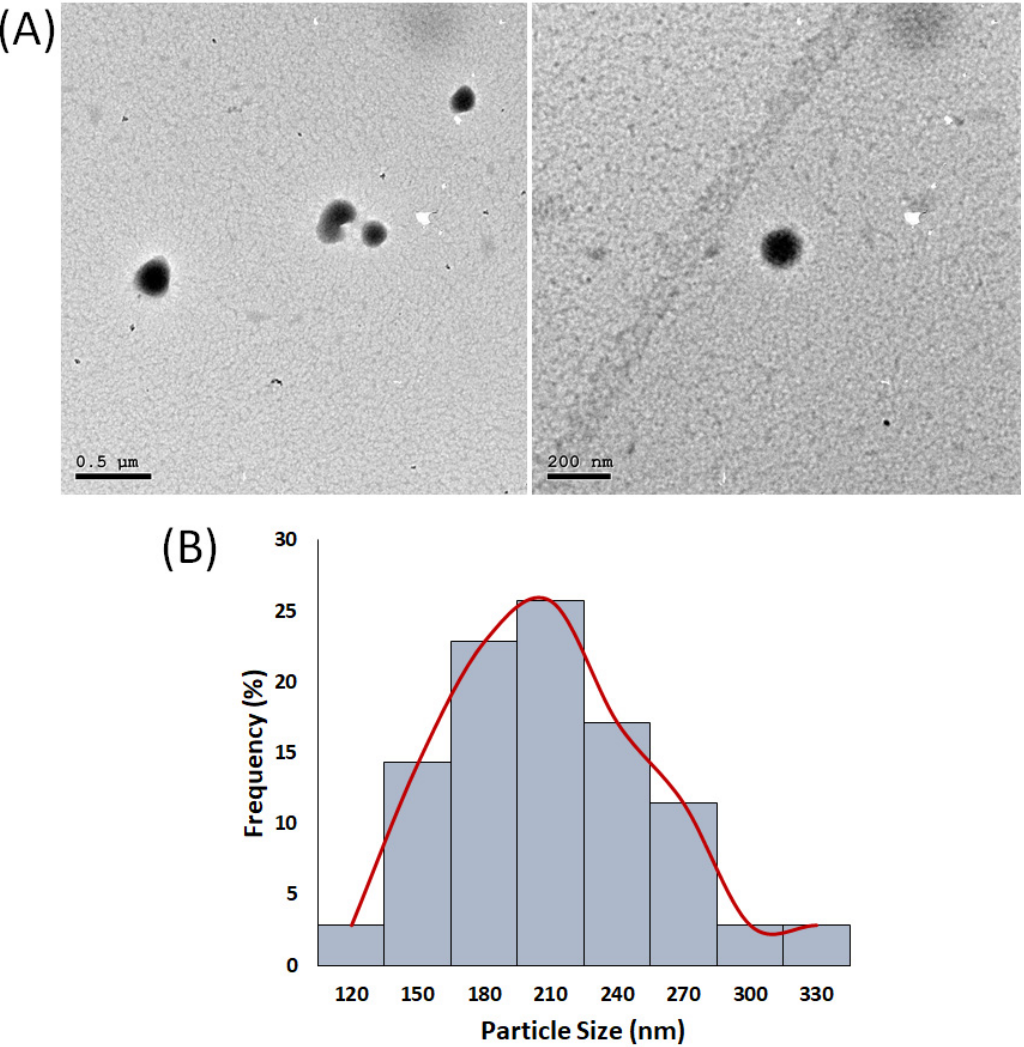
Figure 2. ( A ) Transmission electron microscopy (TEM) images of the optimal H/CS/PLGA NPs formulation. ( B ) Particle size (nm) histogram of the optimal H/CS/PLGA NPs formulation, produced using the image processing program Image J (NIH, Bethesda, MD, USA).